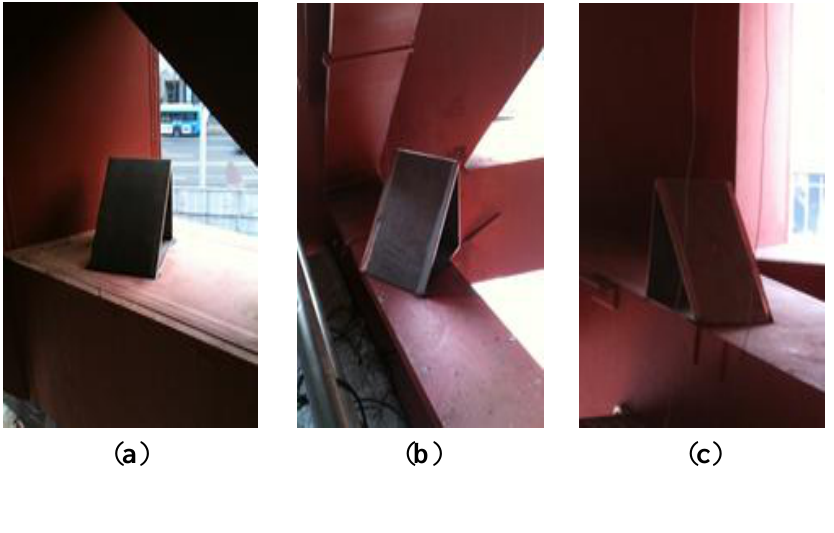
Figure 8. Triangle module installed at the measured point: ( a ) point 1, ( b ) point 2, and ( c ) point